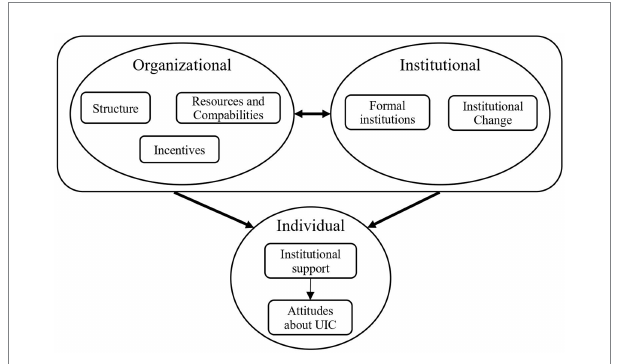
FIGURE 1 Theoretical model with the domains and dimensions of T-Rs perception of scientific-technological